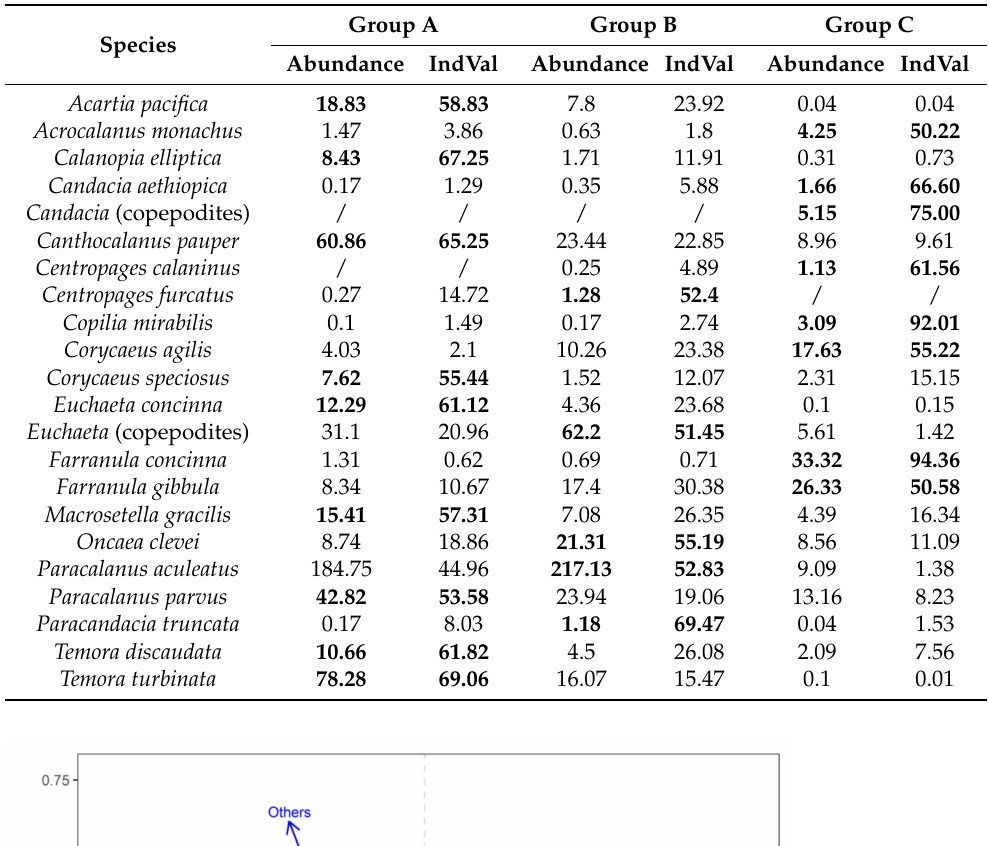
Table 2. Mean abundance (inds. m − 3 ) and IndVal (%) of indicator species in different cluster groups (Figure 3).